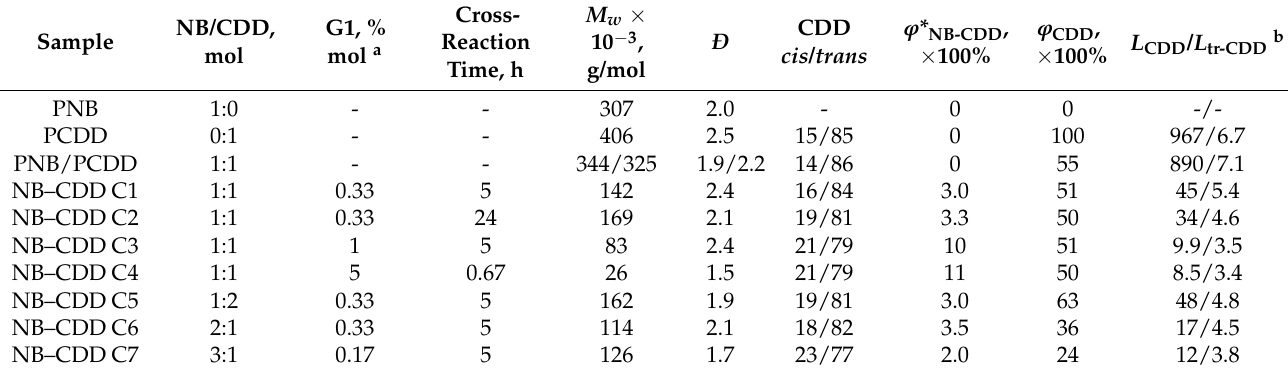
a Relative to the amount of C=C bonds in macromolecules. b Calculated as L 2 ) − 1 assuming the tr-CDD = (1 − ϕ CDD-CDD · ϕ tr − CDD /( ϕ CDD ) random distribution of trans and cis C=C bonds in CDD sequences. The molar mass of the polymers was determined by gel permeation chromatogra- phy (GPC) on a Waters (Milford, USA) high-pressure chromatograph equipped with a column, with tetrahydrofuran as a solvent, a flow rate of 1 mL/min, a sample volume of 100 µ L, a column temperature of 313 K, and a sample concentration of 1 mg/mL. The average molar mass and its dispersity ( Ð ) were calculated by a standard procedure relative to polystyrene standards. Nuclear magnetic resonance (NMR) measurements were carried out at room tem- at 150.93 MHz ( 13 C NMR); CDCl 3 (Aldrich, Milwaukee, WI, USA) was used as solvent. Chemical shifts δ were reported in parts per million relative to the residual CHCl 3 sig- nal as an internal reference standard. Signal assignments are listed in [32,38]. The av- erage lengths of NB and CDD sequences in the multiblock copolymer, L NB and L CDD , were calculated from the integral intensities of homo- (NB–NB, CDD–CDD) and hetero- (NB–CDD, CDD–NB) dyad signals in the 13 C NMR spectra as L NB = [ I (C=C NB–CDD ) + (Figure 1). The growth of heterodyad content in the course of the reaction indicates a decrease in L NB and L CDD , which are combined in the copolymer blockiness parameter, λ = 1 − 1/ L NB − 1/ L CDD . Standard DSC thermograms were recorded on a Mettler TA 4000 (Greifensee, Switzer- land) system at a rate of 10 K/min under argon flow of 70 mL/min in the range from 193 to 373 K. A thermal successive self-nucleation and annealing (SSA) protocol common for two samples is shown in Figure 2. It is characterized by a higher temperature limit of 383 K set for 5 min, a standard crystallization temperature T c = 233 K maintained for 2 min, and a set of self-nucleation temperatures T si starting at 355 K down to 300 K with a step (fractionation window) of 5 K and a fractionation time of 19 min at each T s and a cooling/heating rate of 20 K/min. Single-step annealing was performed by heating a sample up to 383 K and, 5 min later, cooling down to T c set for 2 min, heating up to a temperature 5 K above the end of the melting curve for this sample, annealing for a given time (usually 30 min), cooling down to T c set for 3 min, and then recording the heating thermogram, a cooling/heating rate of 10